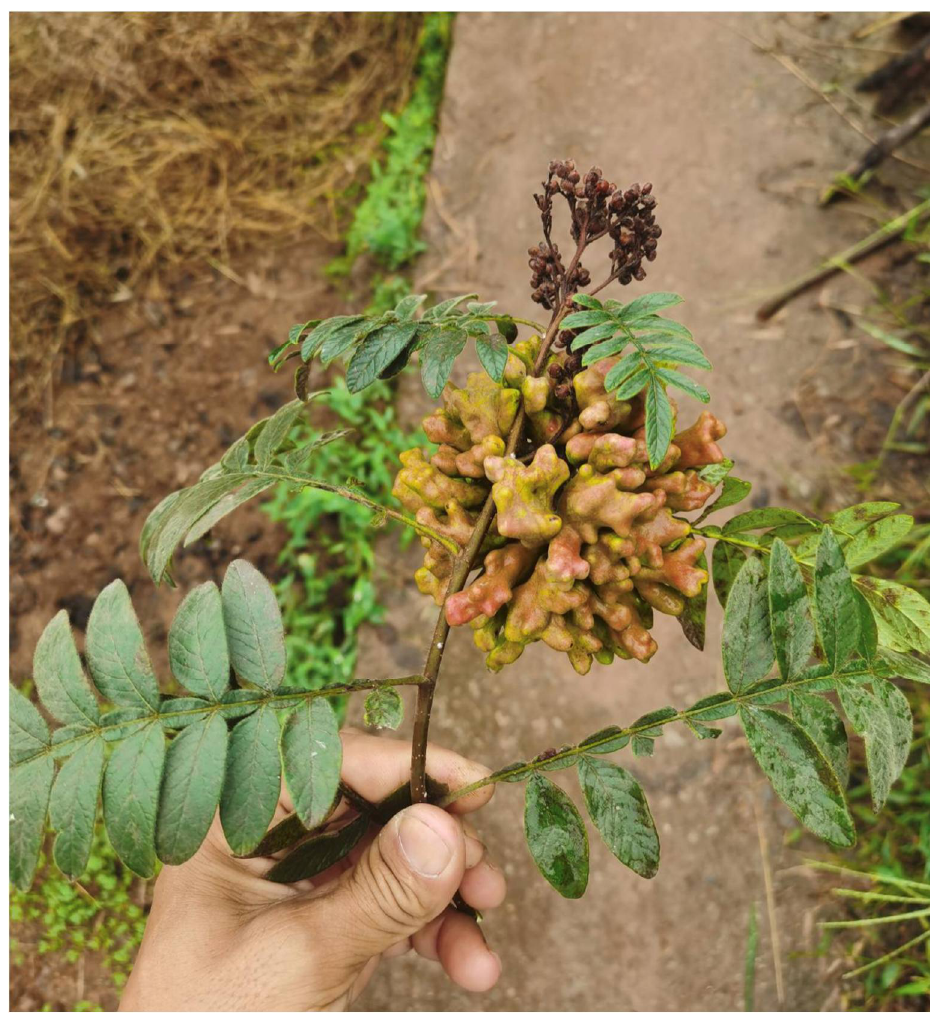
Figure 10. Galls formed by Qiao jinshaensis sp. nov. on Rhus wilsonii .